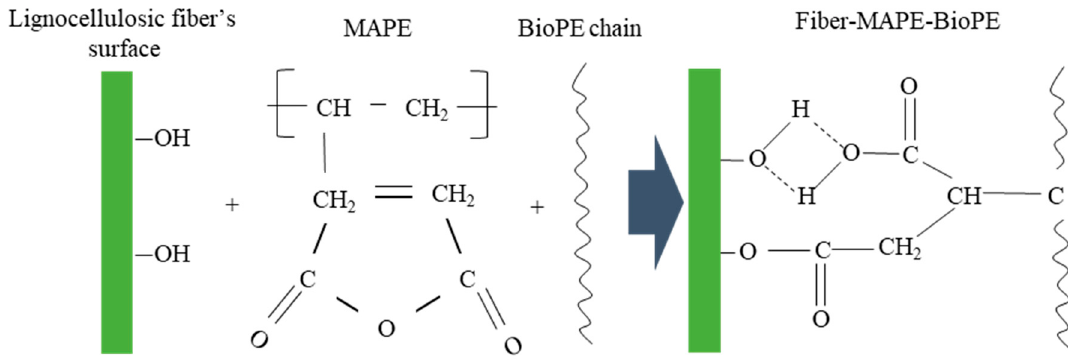
Figure 3. Illustration of maleic anhydride polyethylene (MAPE) interaction between the fiber and the matrix.